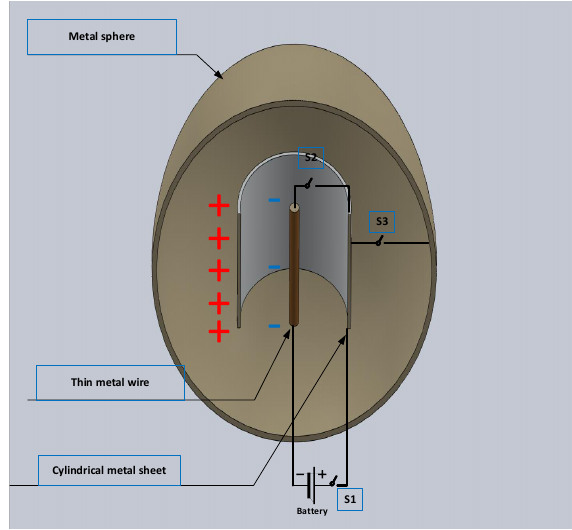
Figure 2. Field interaction of the proposed